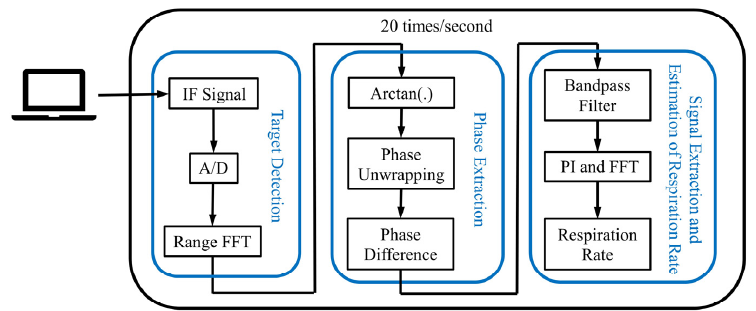
Figure 4. Data processing scheme. The sensor uses a frequency set to capture 20 times per second and is processed to determine the final breathing rate.